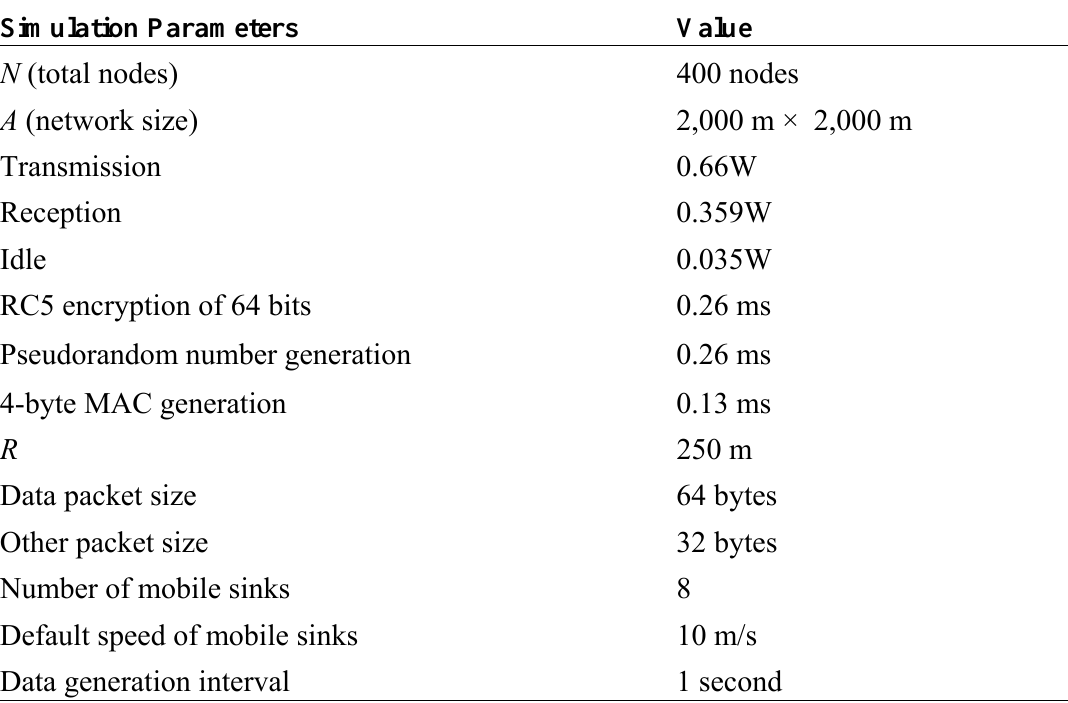
Table 3 . Simulation parameters and defined